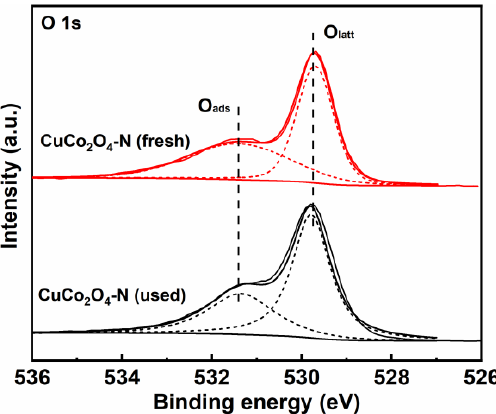
Figure 11. XPS spectra of O 1 s of CuCo 2 O 4 -N catalyst before and after reaction.